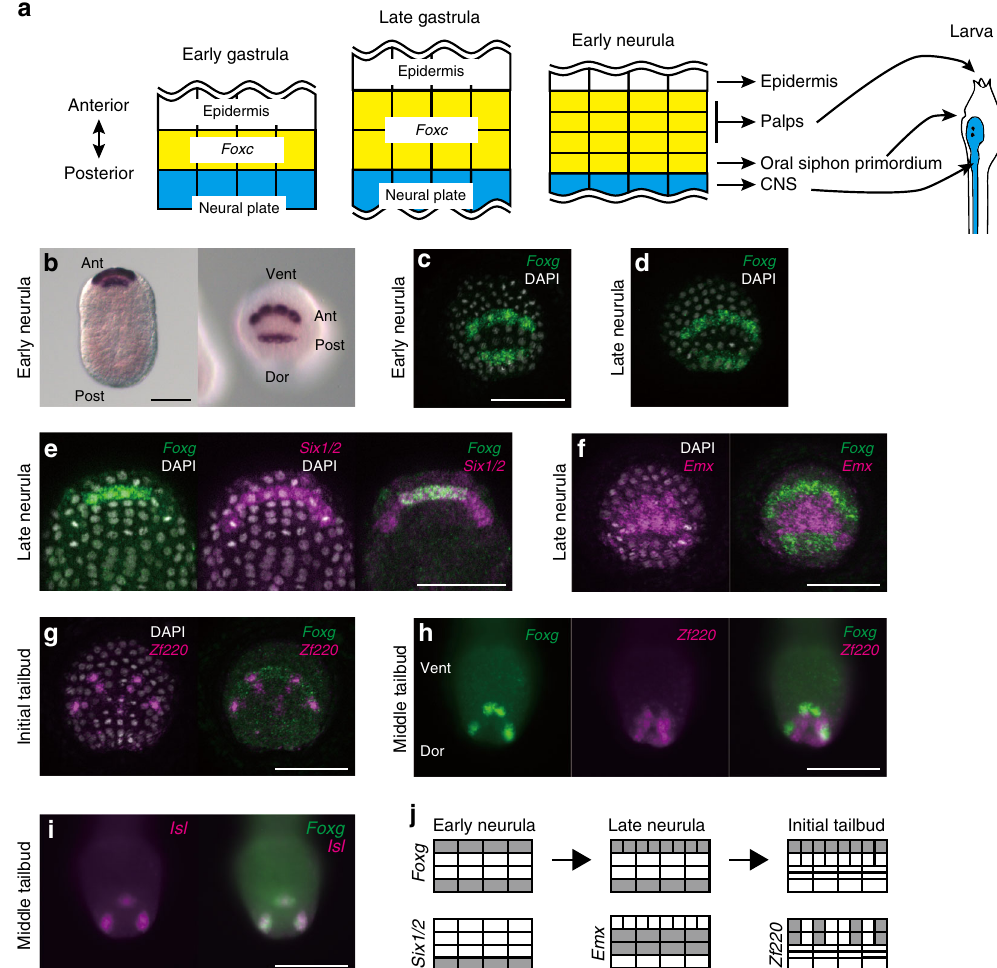
Fig. 1 Foxg is speci fi cally expressed in two rows of the anterior border of the neural plate. a Schematic illustrations of the anterior border of the neural plate in ascidian embryos. Epidermal cells, neural plate cells, and the intervening cells are represented by white, cyan, and yellow rectangles, respectively. b – d Foxg expression revealed by chromatic and fl uorescence in situ hybridization at the early and late neurula stages. Foxg is initially expressed in two separate rows during the neurula stage, and cells in the anterior row divide along the mediolateral axis until the late neurula stage. e – i Double fl uorescence in situ hybridization showing expression of e Foxg (green) and Six1/2 (magenta), f Foxg (green) and Emx (magenta), g , h Foxg (green) and Zf220 (magenta), and i Foxg (green) and Isl (magenta) at the late neurula to middle tailbud stages. Photographs are Z-projected image stacks overlaid in pseudocolor. The brightness and contrast of these photographs were adjusted linearly. Nuclei stained by DAPI are shown in gray in some photographs. j Depictions of the expression patterns of Foxg, Six1/2 , Emx , and Zf220 in the neural plate border at the neurula stage. b , e Dorsal views in which the anterior is up. c , d , f – i Anterior views in which the ventral side is up. Ant anterior, Post posterior, Dor dorsal, Vent ventral. Scale bars represent 50 μ